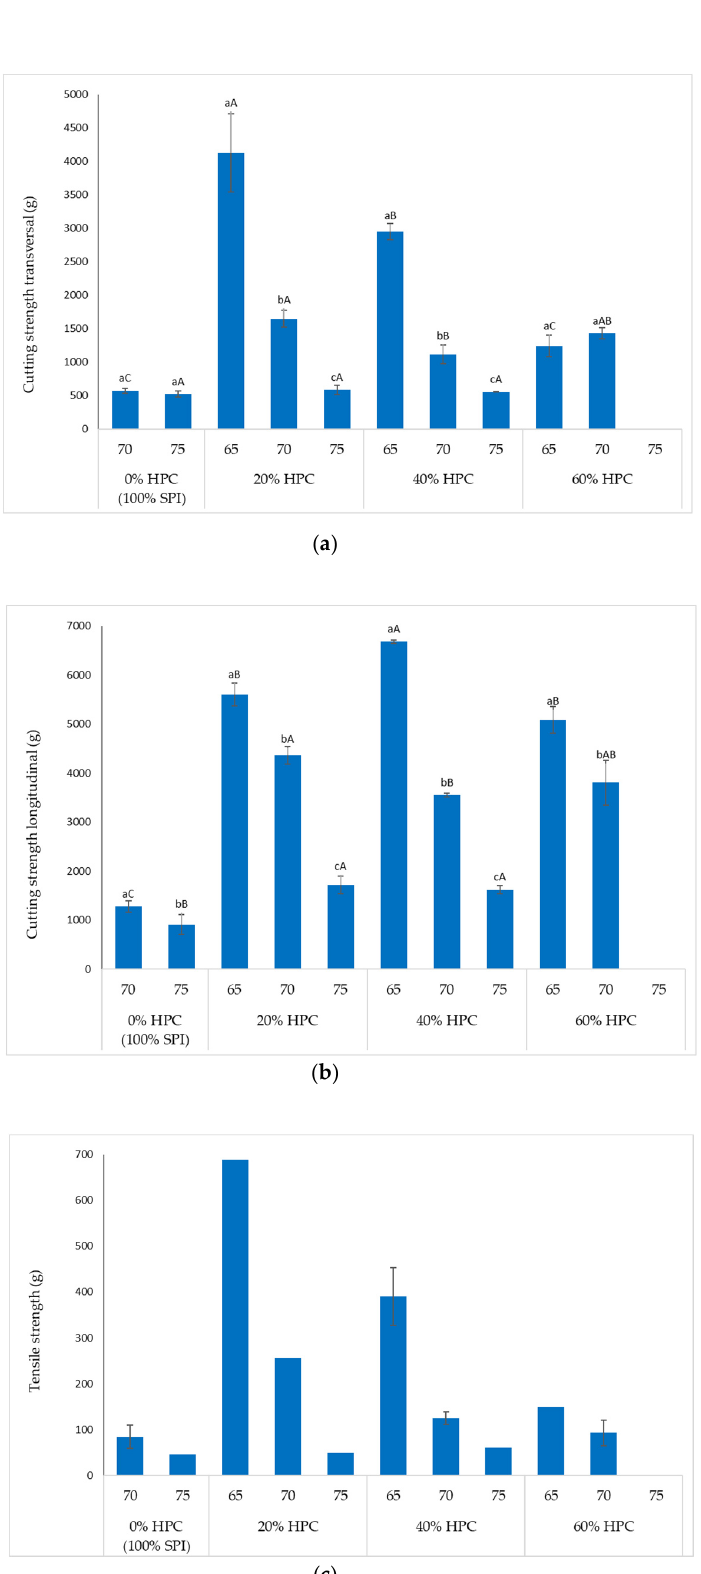
Figure 6. ( a ) Transversal cutting strength; ( b ) longitudinal cutting strength; ( c ) tensile strength of di ff erent HMMA formulations at each target moisture contents. Bars represent the mean ± standard deviation of triplicate measurements. Di ff erent lowercase letters indicate significant di ff erences (Tukey’s test, p < 0.05) within the same HMMA formulation. Di ff erent uppercase letters indicate a significant di ff erence between di ff erent HMMA formulations. Bars without standard deviation represent only one measurement.